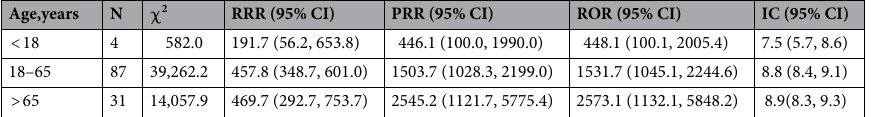
Table 4. The association between periostitis and voriconazole by age. RRR relative reporting ratio, CI confidence interval, PRR proportional reporting ratio, ROR reporting odds ratio, IC information components.